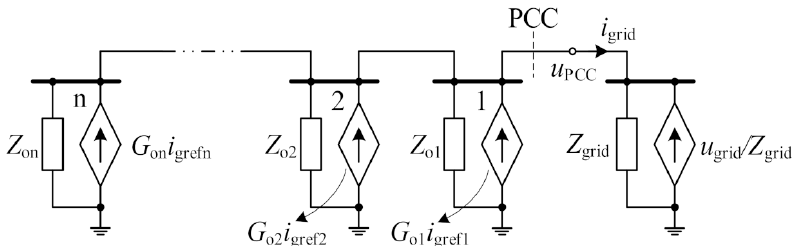
Figure 12. Impedance network of converter cluster system based on Norton equivalent